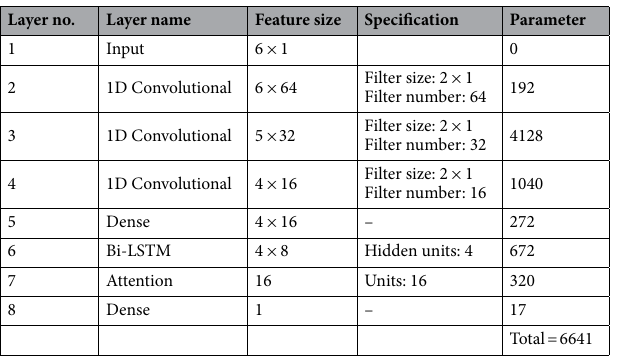
Table 4. Layer properties of proposed attention-based hybrid 1D CNN-BiLSTM model.